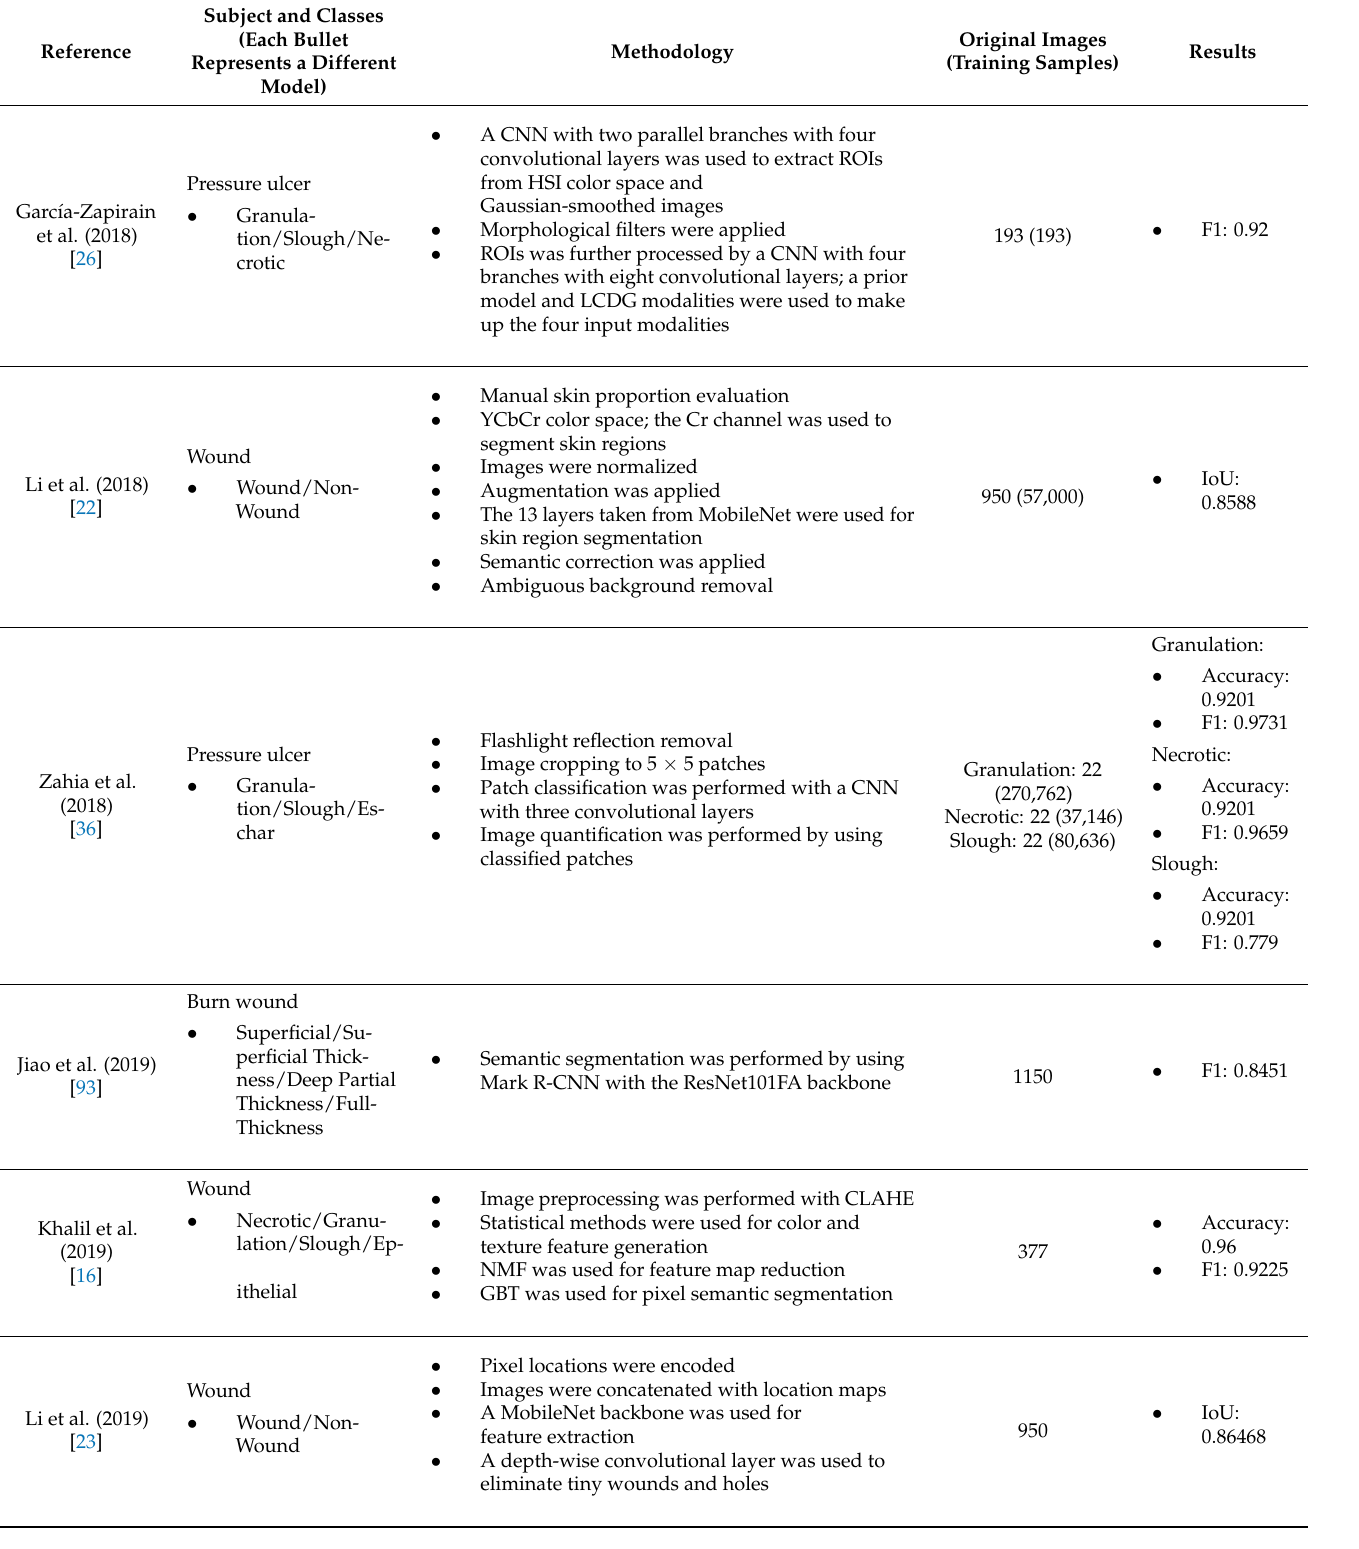
Table 6. Summary of studies on the semantic segmentation of chronic